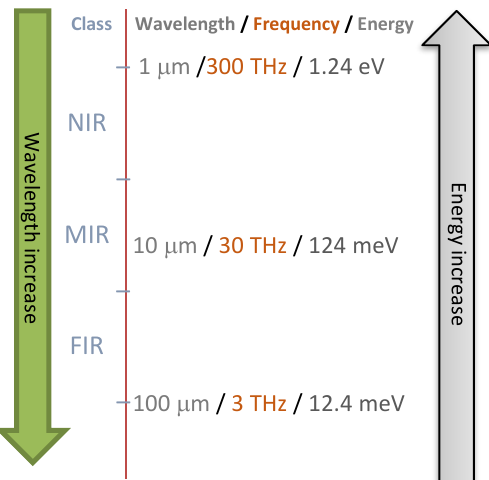
Figure 4. Vibrational spectroscopies are commonly used in the assessment of food quality and